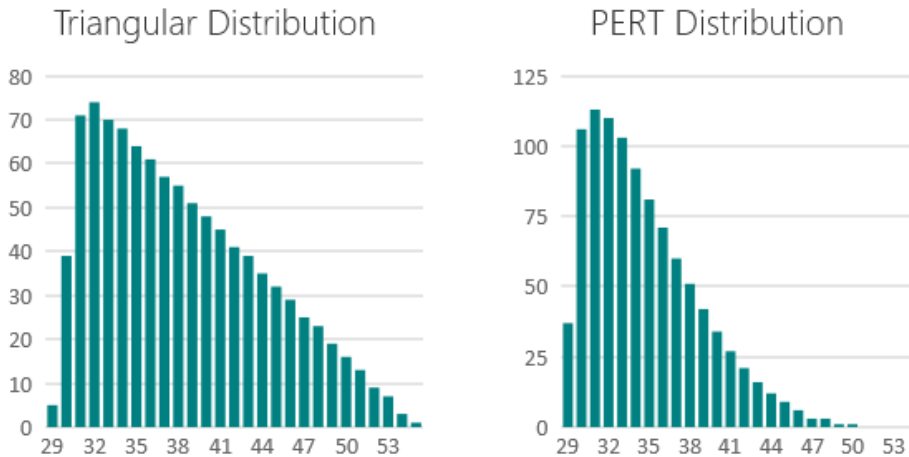
Figure 7. Comparison of triangular and PERT distributions for the assumed “Project implementation stage” assumptions (i.e., minimum, maximum and mode values).